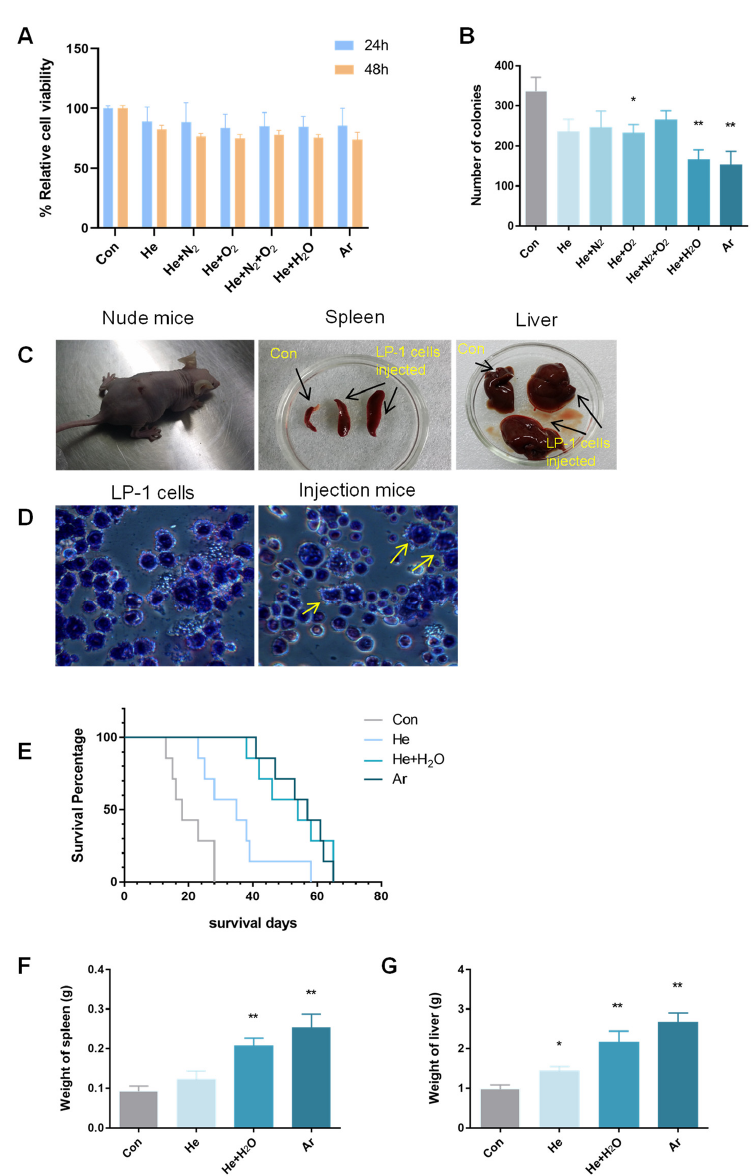
Figure 1. Plasma inhibited MM cell colony formation in vitro and engraftment in vivo. ( A ) Cell viability at 24 h and 48 h after pure He, He + O 2 (0.5%), He + N 2 (0.5%), He + O 2 (0.5%) + N 2 (0.5%), He + H 2 O (1%), and pure Ar plasma treatment. ( B ) CFC assays were performed after various plasma treatments. Cells were plated at a concentration of 10,000 per mL (LP-1). The number of colonies was counted and presented as the mean ± SD ( n = 3). ( C ) Construction of the MM mouse xenograft model, and images of the spleens and livers of control mice and LP-1 mice. ( D ) Giemsa Staining with LP-1 cells and the bone marrow of the LP-1 mice, arrows represent LP-1 cells in mice bone marrow. ( E ) Kaplan–Meier survival analysis ( n = 7). The x -axis represents the number of survival days from injection to the development of hind leg paralysis, and the y -axis represents the survival percentage. Then, ( F ) spleens and ( G ) livers were collected and weighed. Data represent the mean ± SD; * p < 0.05; ** p < 0.01 (Student’s t test).